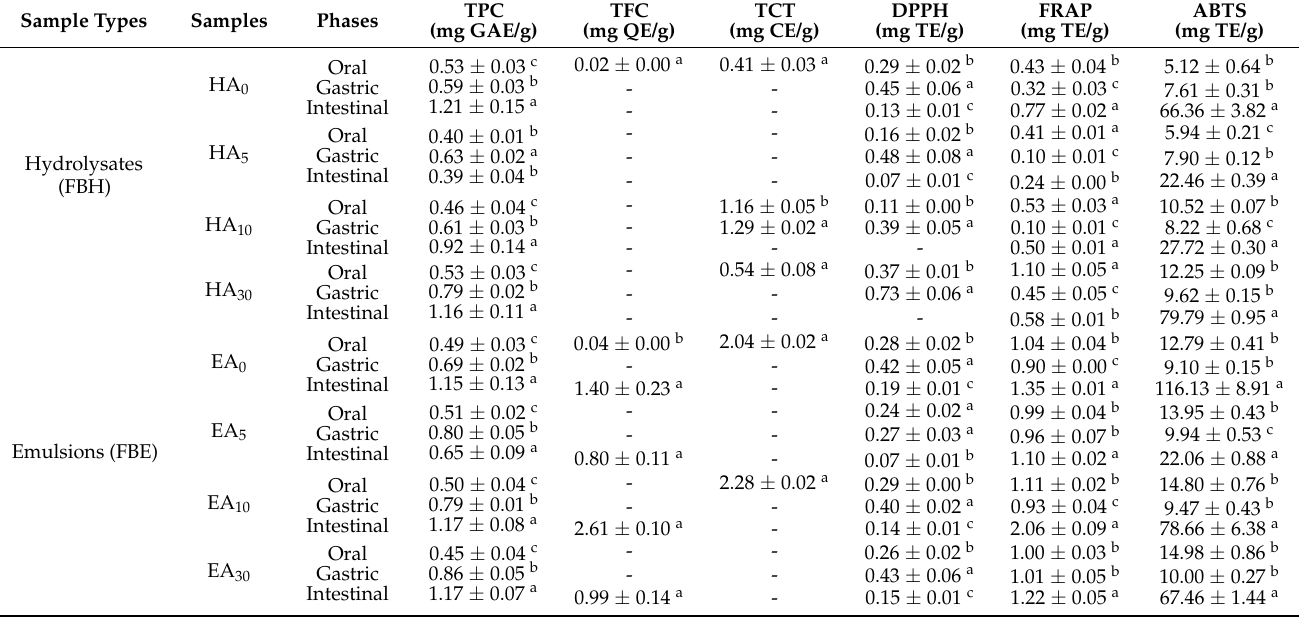
Table 3. Phenolic estimations of faba bean hydrolysates (FBH) and emulsions (FBE) across in vitro digestion